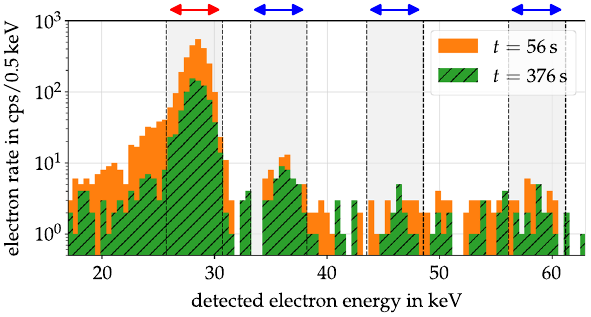
Fig. 5 Observedenergyspectrumfroma 83m Krsourcebeforeandafter removing electrons. The spectrum at t = 56 s corresponds to nominal conditions before any application of magnetic pulses. This is compared to the spectrum at t = 376 s after applying several magnetic pulses in one cycle (indicated by vertical lines in the bottom plot of Fig. 4). The figure also indicates the low- and high-energy ROIs used in the analysis